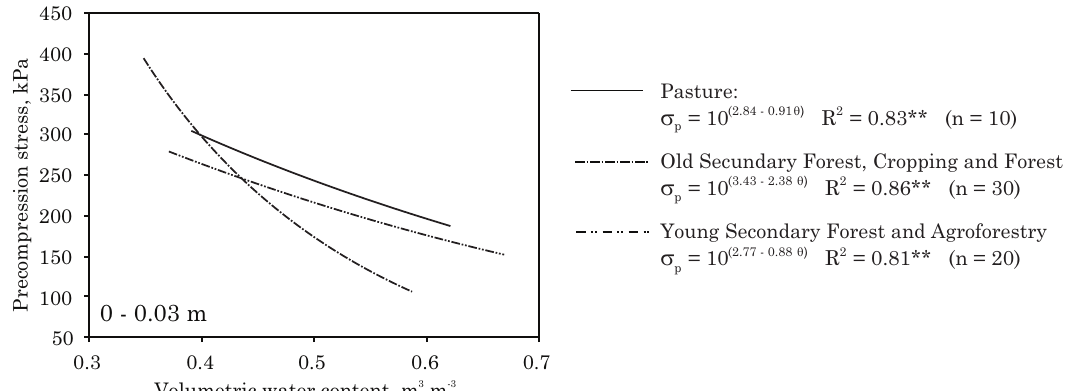
Figure 2. Load bearing capacity models for the Cambisol at 0 - 0.03 m depth under different land use